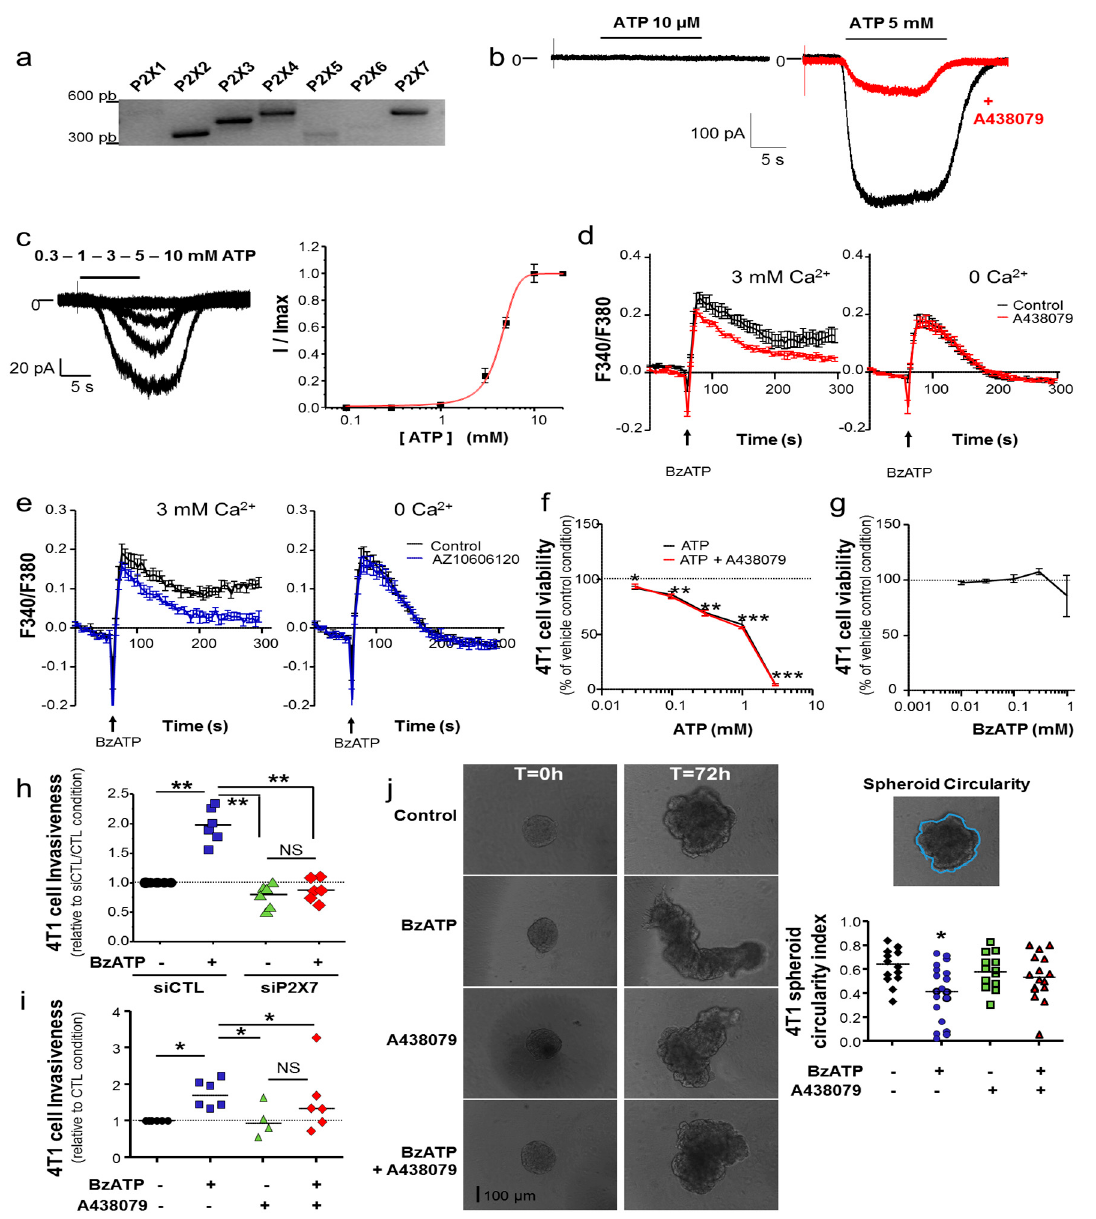
Figure 1. P2X7R is functional in 4T1 mouse mammary cancer cells and drives cell invasiveness. ( a ) RT-PCR analysis of P2X mRNA expression. ( b ) Representative whole-cell patch clamp recordings